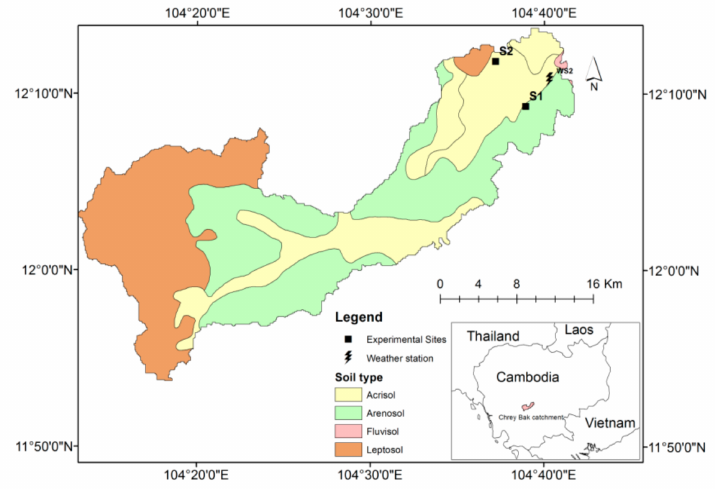
Figure 1. Experimental sites at Chearov (S1) and Ou Roung (S2), located in the Chrey Bak